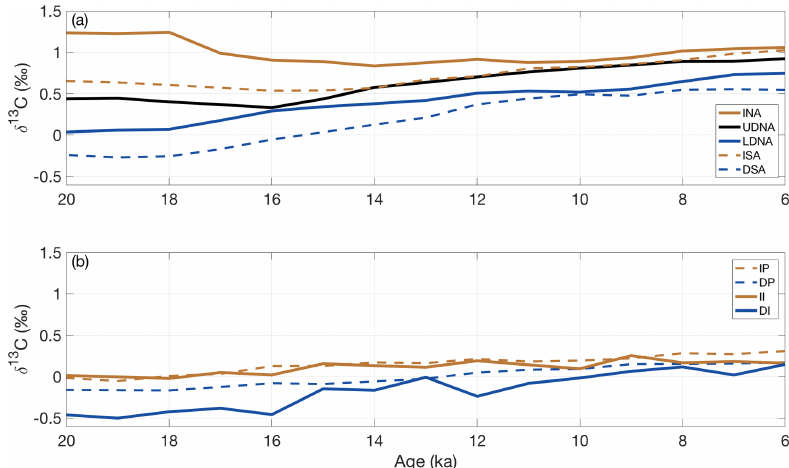
Figure 3. Regional stacks for the (a) Atlantic and (b) Indian and Pacific oceans. Note the x and y axes are identically scaled. INA is the intermediate North Atlantic; UDNA is the upper deep North Atlantic; LDNA is the lower deep North Atlantic; ISA is the intermediate South Atlantic; DSA is the deep South Atlantic; II is the intermediate Indian; DI is the deep Indian; IP is the intermediate Pacific; DP is the deep